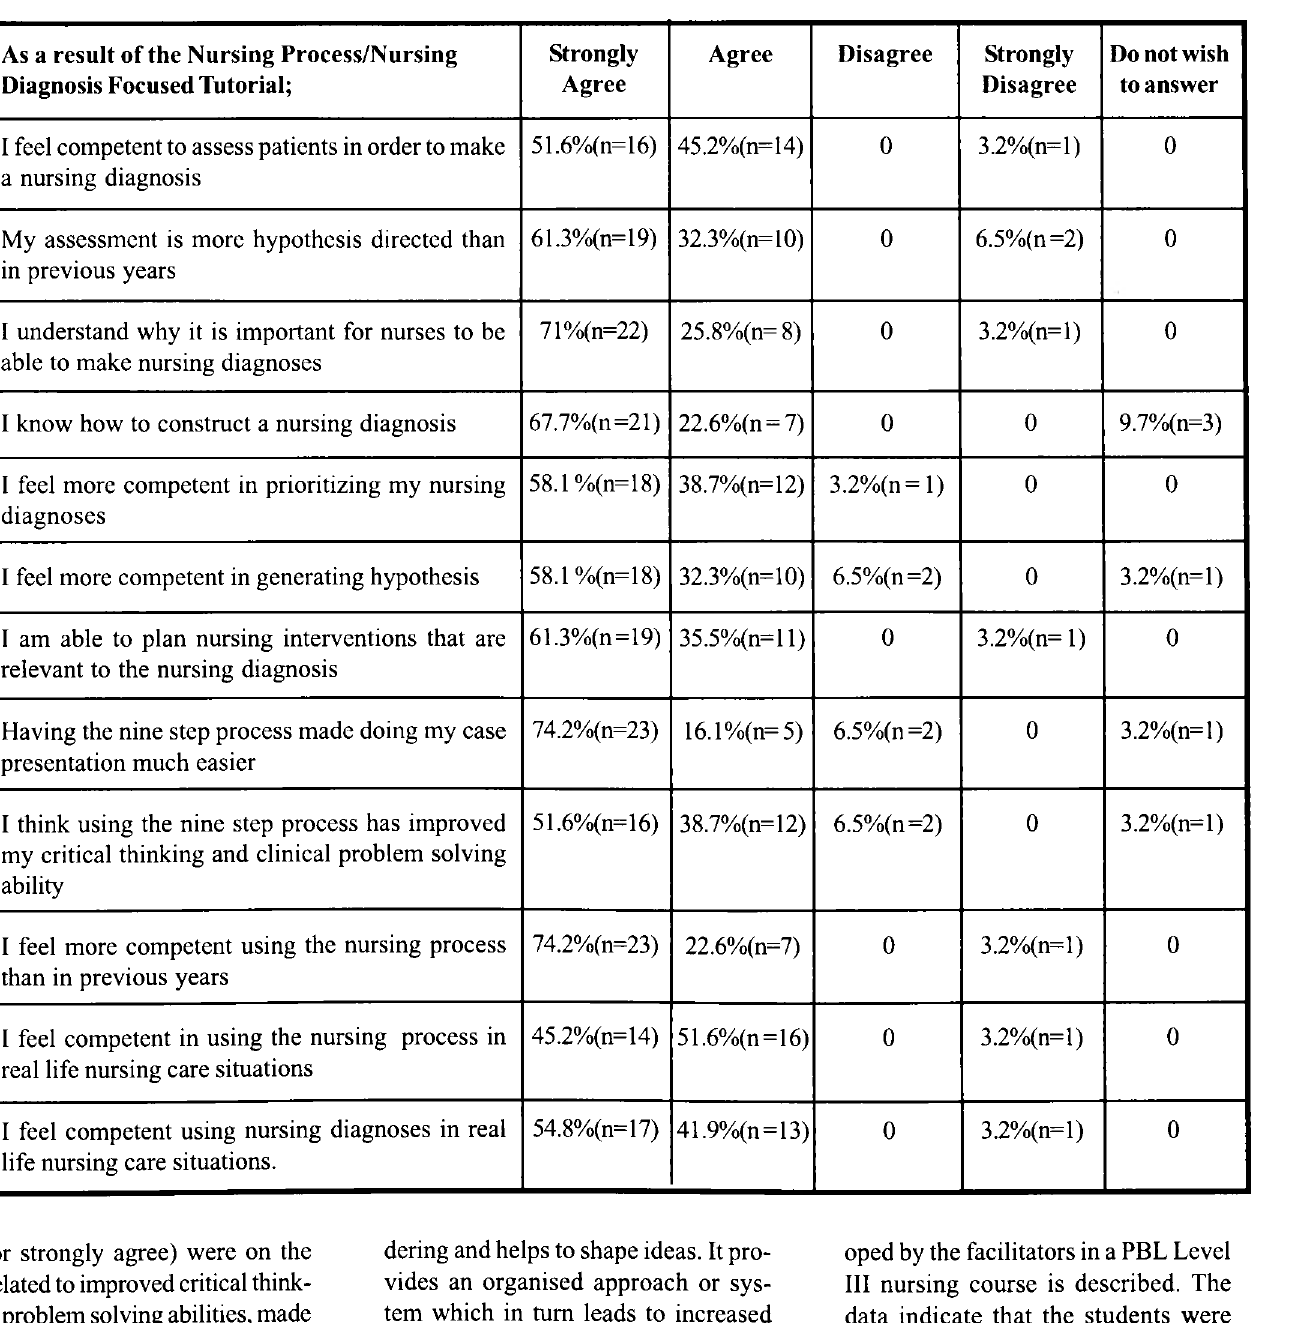
Table 1: Frequencies on student satisfaction questionnaire